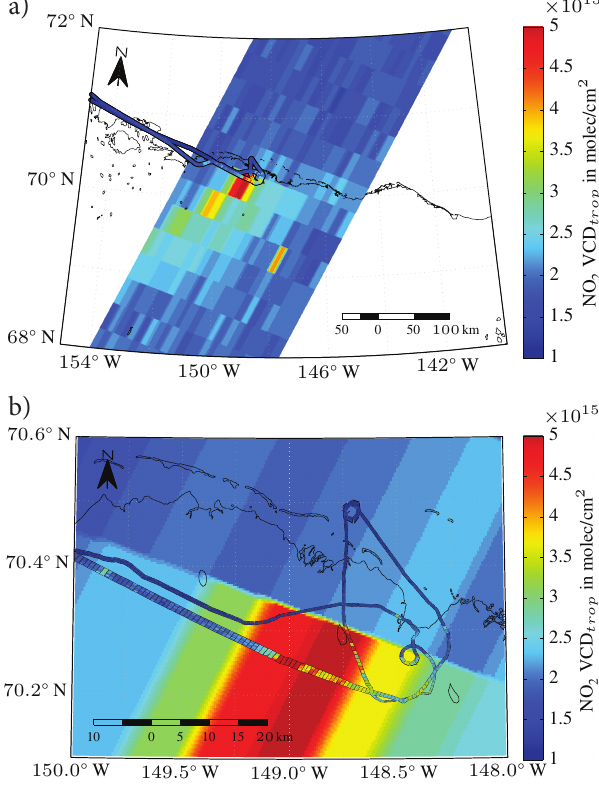
Figure 23. Comparison of NO 2 VCDs around Prudhoe Bay, mea- sured by GOME-2 (DLR, 2012) and HAIDI: (a) The GOME-2 satellite swath covered Prudhoe Bay on 30 March at 21:02UTC, 4.5h prior to the measurements with HAIDI. As can be seen, the satellite data shows a large NO 2 plume propagating in wind direc- tion. Measurements from HAIDI are indicated by color-coded dots. (b) The enlarged view shows that enhanced NO 2 was only seen on- shore. Due to favorable pixel positions in the satellite swath this can also be confirmed by the GOME-2 measurements, which have a much lower